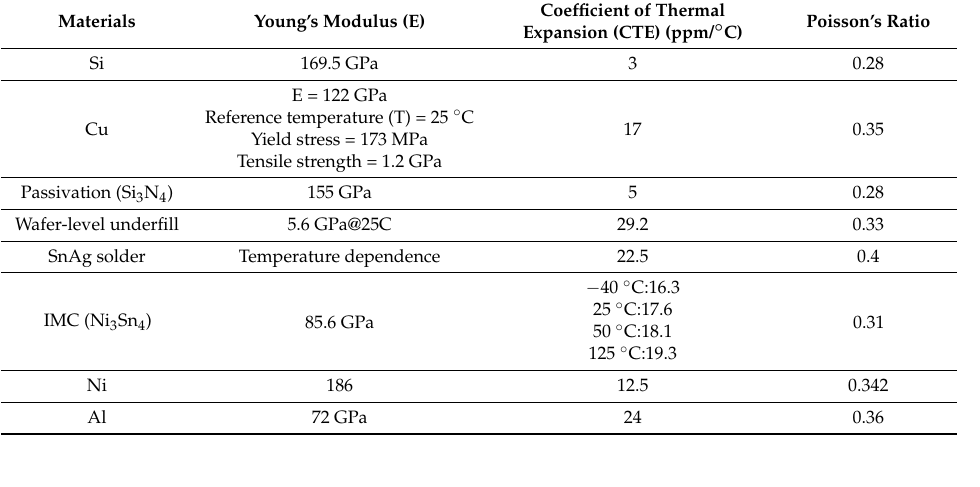
Table 1. List of material properties used to estimate the presented nonlinear finite element analysis (FEA).